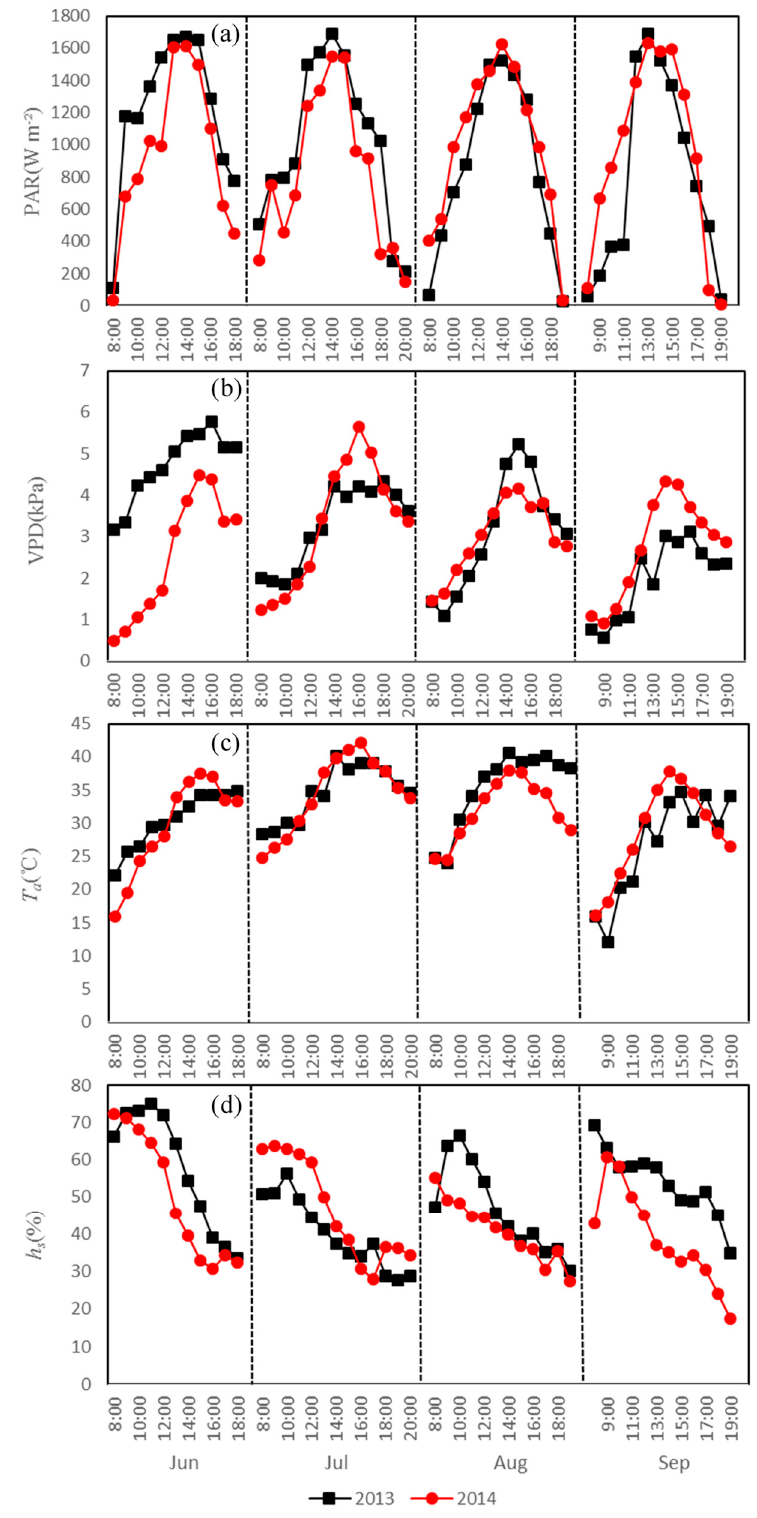
Figure 2. Diurnal variations in ( a ) photosynthetically active radiation (PAR), ( b ) vapor pressure deficit (VPD), ( c ) air temperature ( T a ), and ( d ) relative humidity ( h s ) during the main growing seasons of Populus euphratica in 2013 and 2014. The values in the figure are the averages for each parameter at the same hour on different observational days in each month.